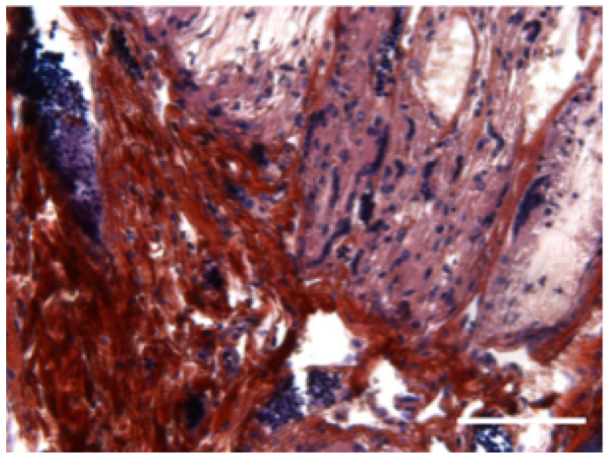
Figure 4. Subcutaneous implantation of hybrid 3D electrospun ‐ nanofibrous implant in mice leads to bone formation: In vivo bone induction in PCL 3D scaffold with human primary osteoblasts microtissues 4 weeks after subcutaneous implantations in nude mice. Scale bar = 100 μ m. n = 5 mice.